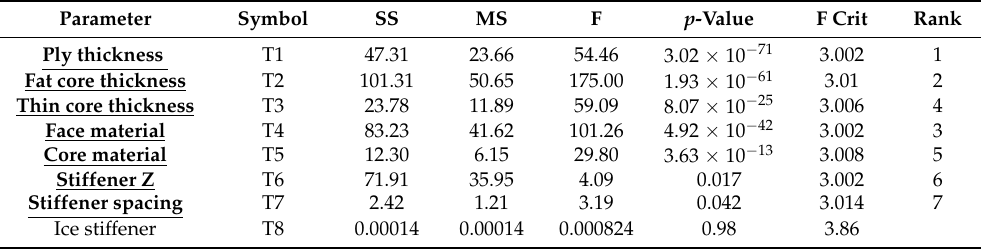
Table 11. ANOVA analysis for stiffened sandwich parameters for SSF. Significant parameters are highlighted in bold and underlined. Order of sensitivity is indicated under rank.